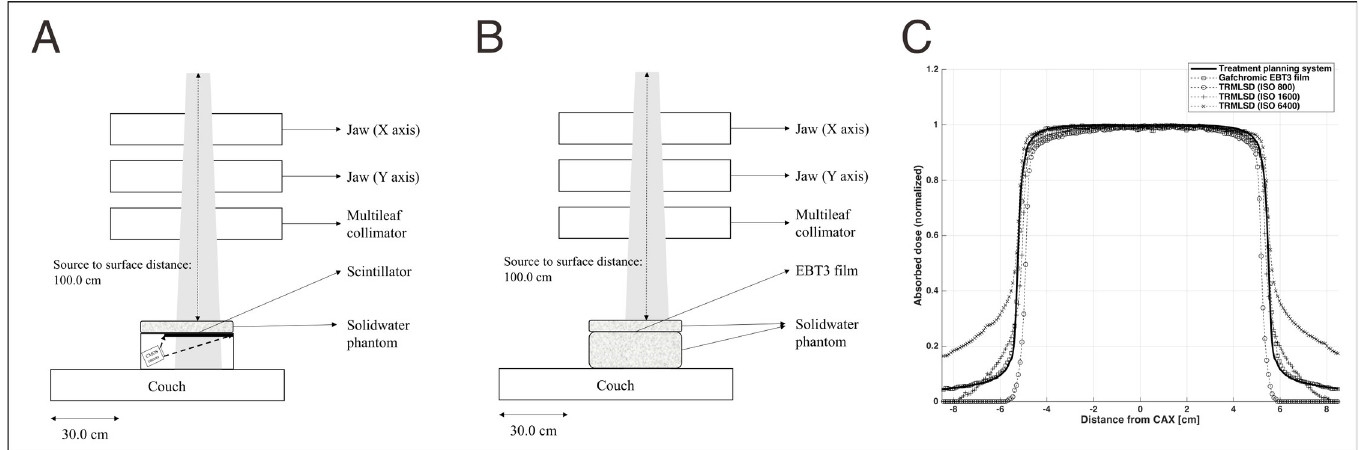
Fig 2. Experimental Setup for (A) the TRMLSD and (B) EBT3 film. (C) The measured profiles normalized to the maximum pixel value. Radiations were delivered at 249 monitor units with a 10.0 × 10.0 cm 2 field for three different ISO values (800, 1600, and 6400) for the TRMLSD.